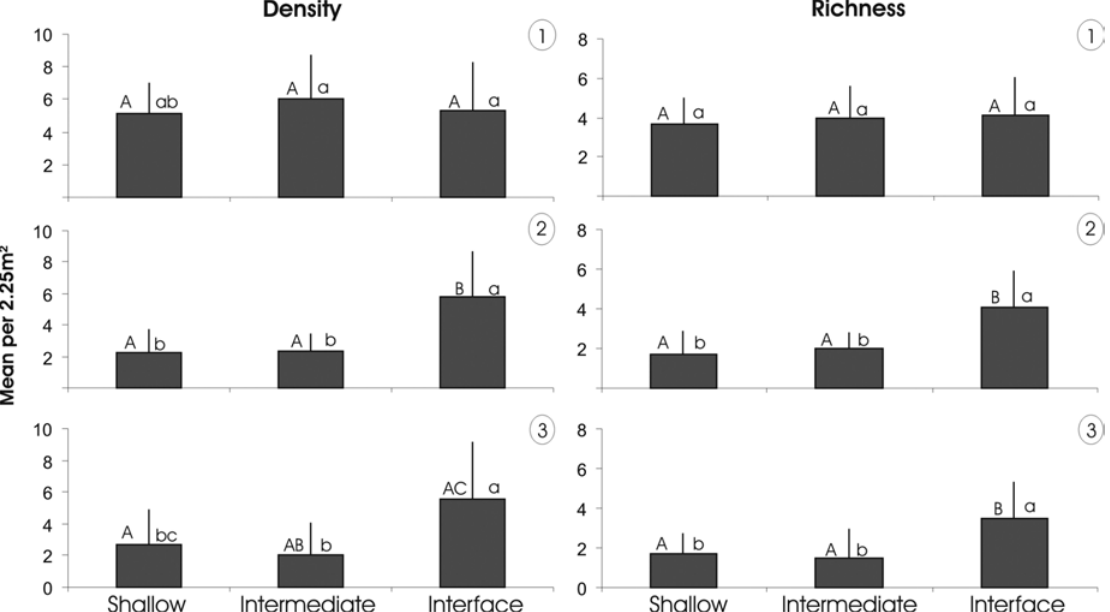
Fig. 2 – Means of density and richness of all species sighted in OD patches at Maramutá reefs. Numbers in circle indicates samples (period); letters above bars indicates homogeneous groups formed by Tukey results. Capital letters refers to comparison depth on the same time while minuscule letters refers to comparison depth on different period.